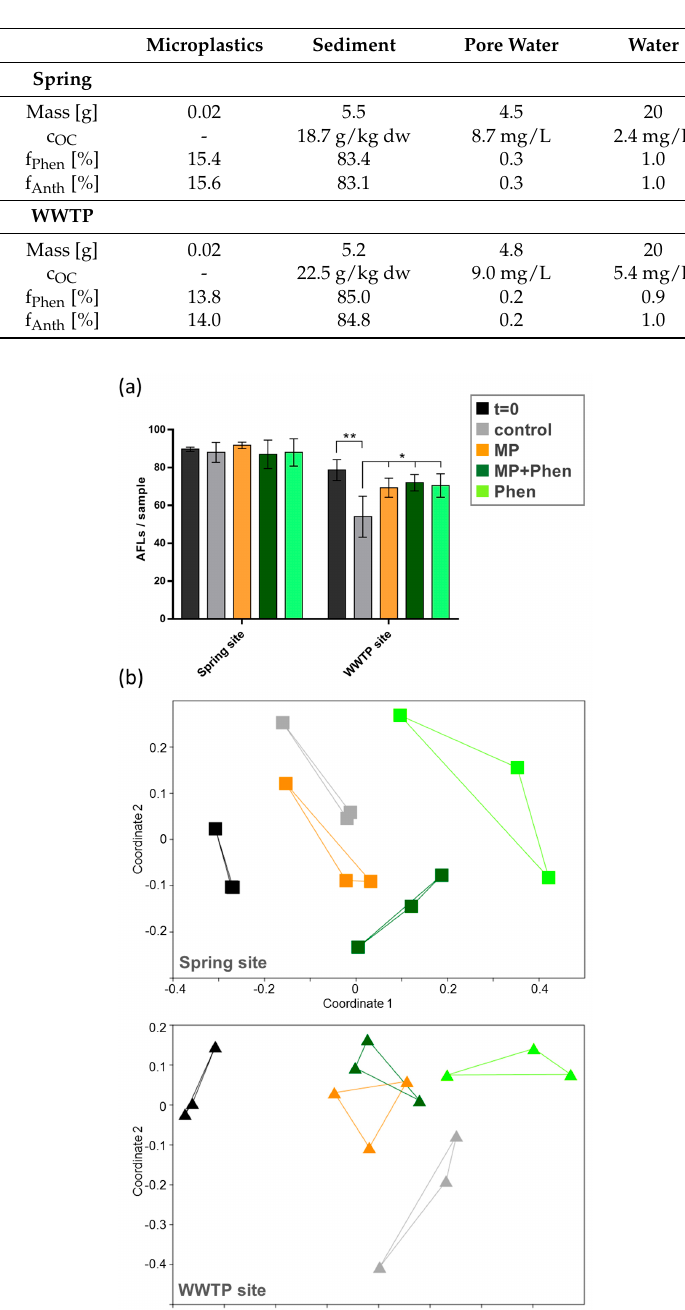
Table 1. Mass of each phase in the batch, their respective organic carbon concentrations (c OC ) and the calculated fraction of phenanthrene (f Phen ) and anthracene (f Anth ) in each phase after equilibration.